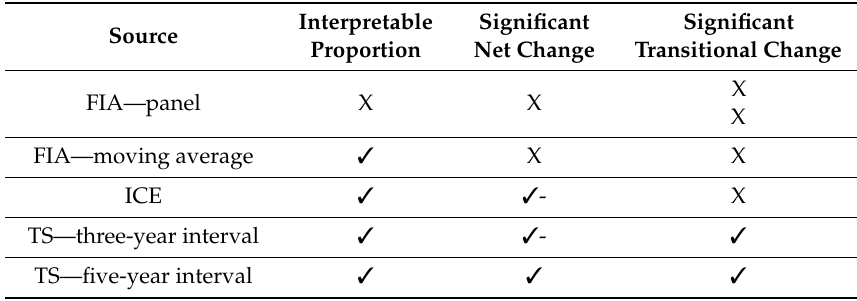
Table 3. Success of variations on our three data sources in delivering interpretable / significant estimates of proportion area and change through time, where (cid:51) indicates success, and X indicates no success. Note that the addition of two-phase estimates would not change the rating for the FIA panel data. Neither would the addition of a relatively accurate (e.g., 85%) post-stratified layer change the results for any of the data